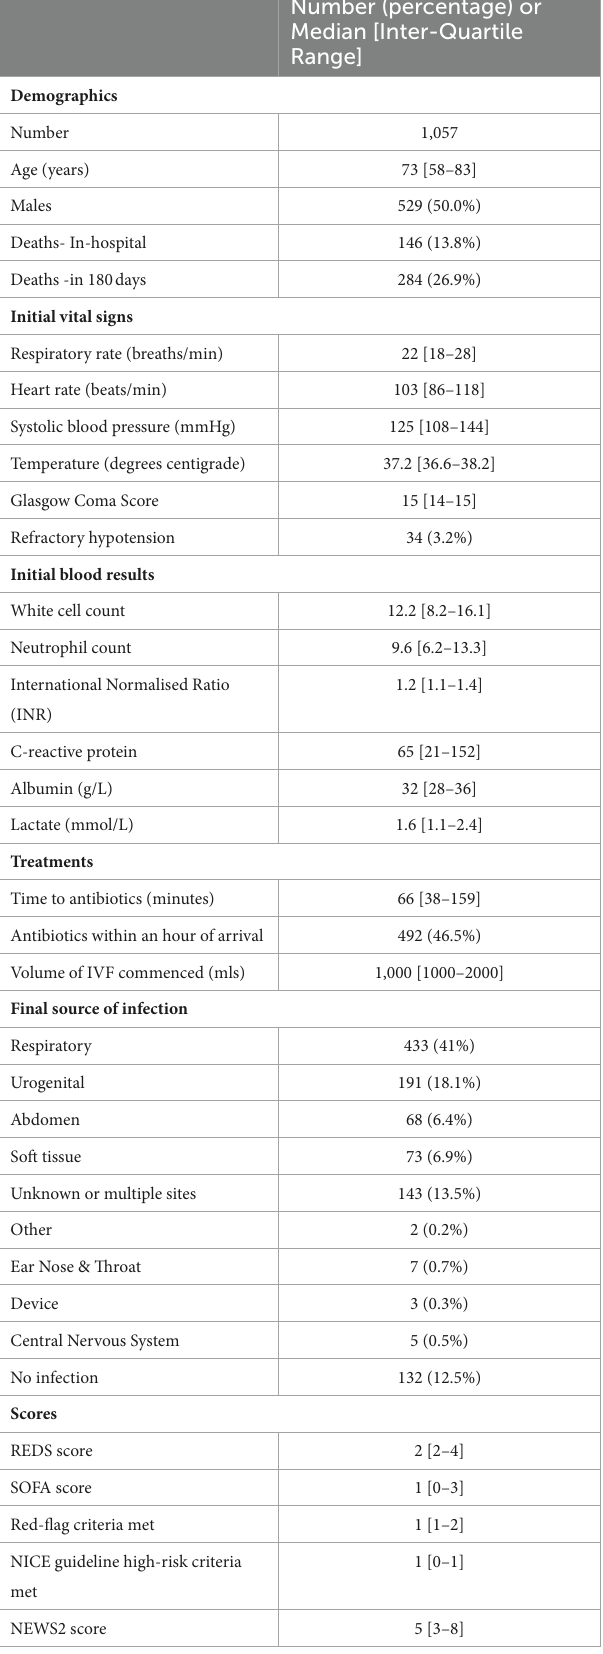
TABLE 1 Baseline variables of the study